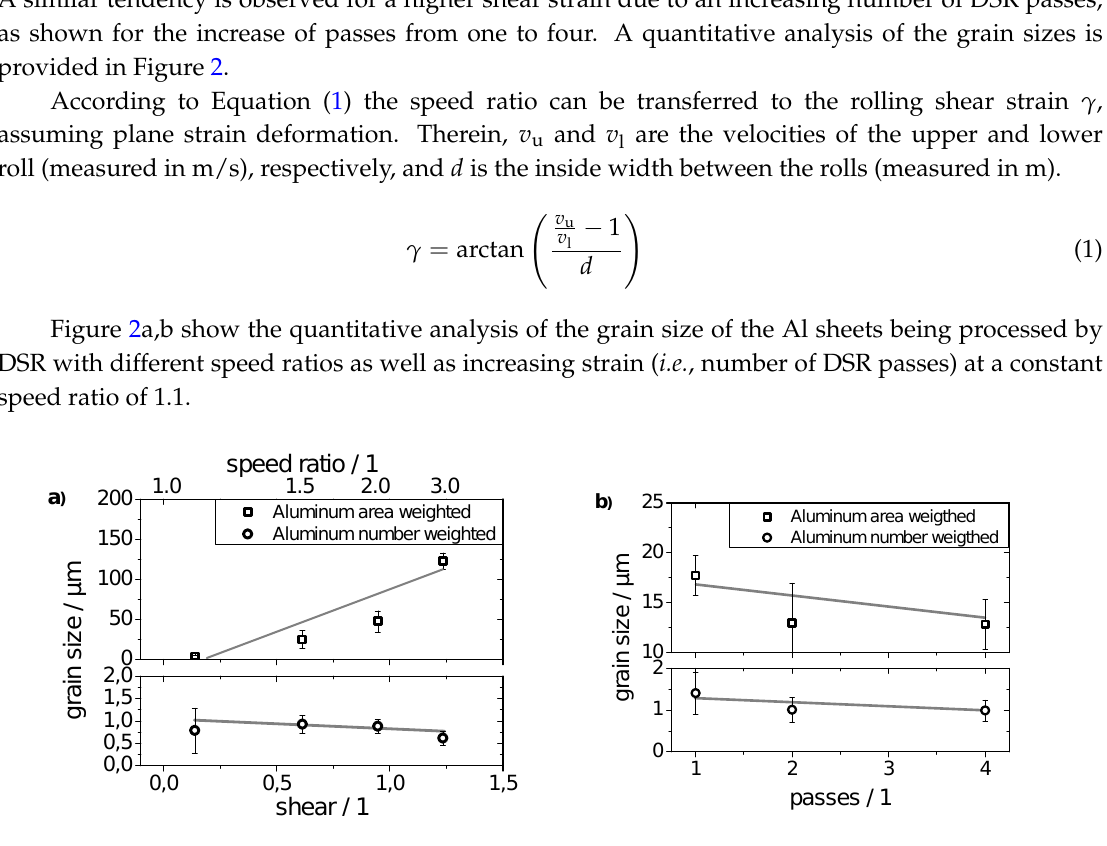
Figure 2. ( a ) Grain size of Al with different weighting methods being applied: grain area with increasing speed ratio, i.e. , amount of shear and ( b ) evolution of the grain size with increasing number of rolling passes (DSR) with a constant speed ratio of 1.1. The weighting methods are described in part A of this